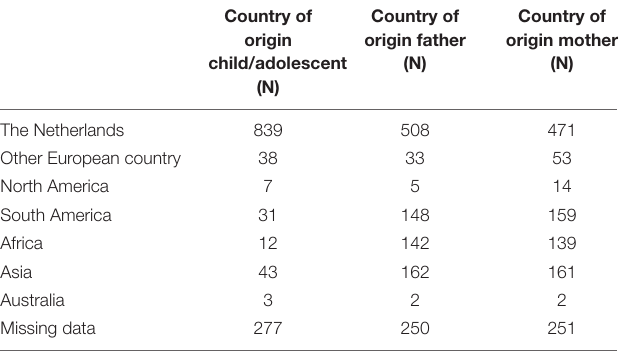
TABLE 2 | Ethnicity of participants, and their parents classified by continent.